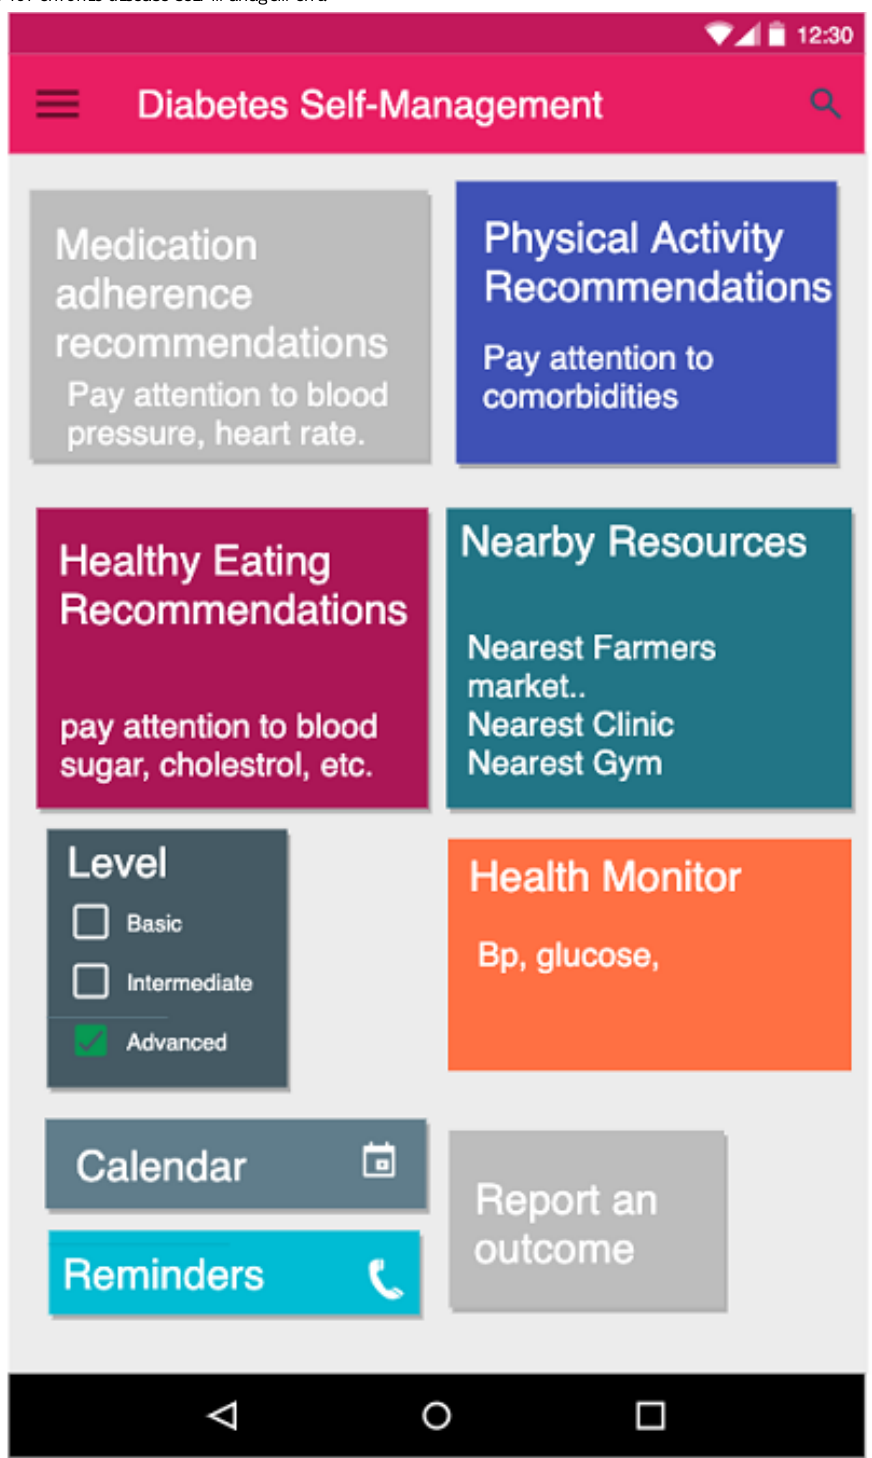
Figure 12. Mobile app for chronic disease